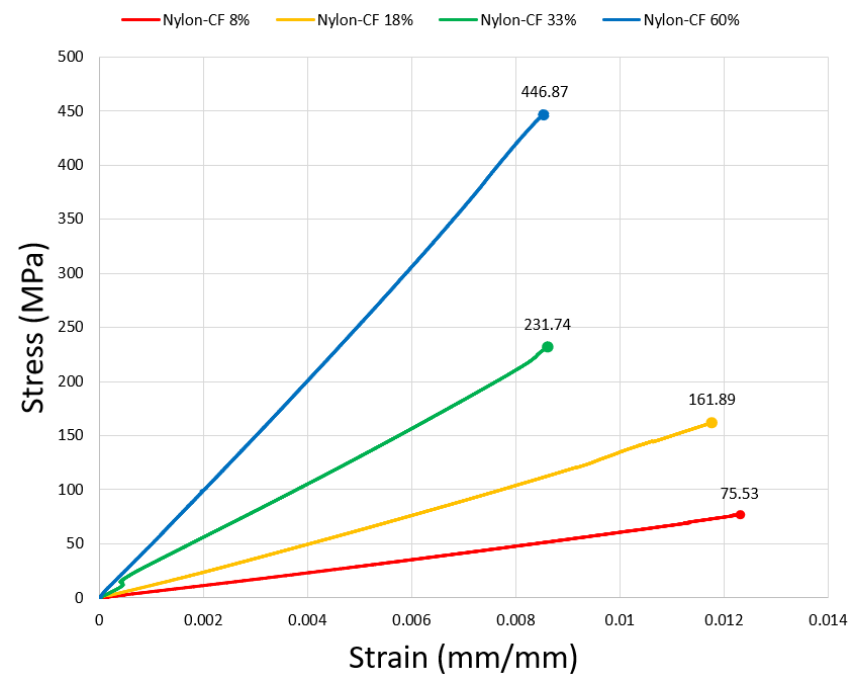
Figure 6. Effect of CF volume fraction on tensile strength of CFRAM nylon-CF.